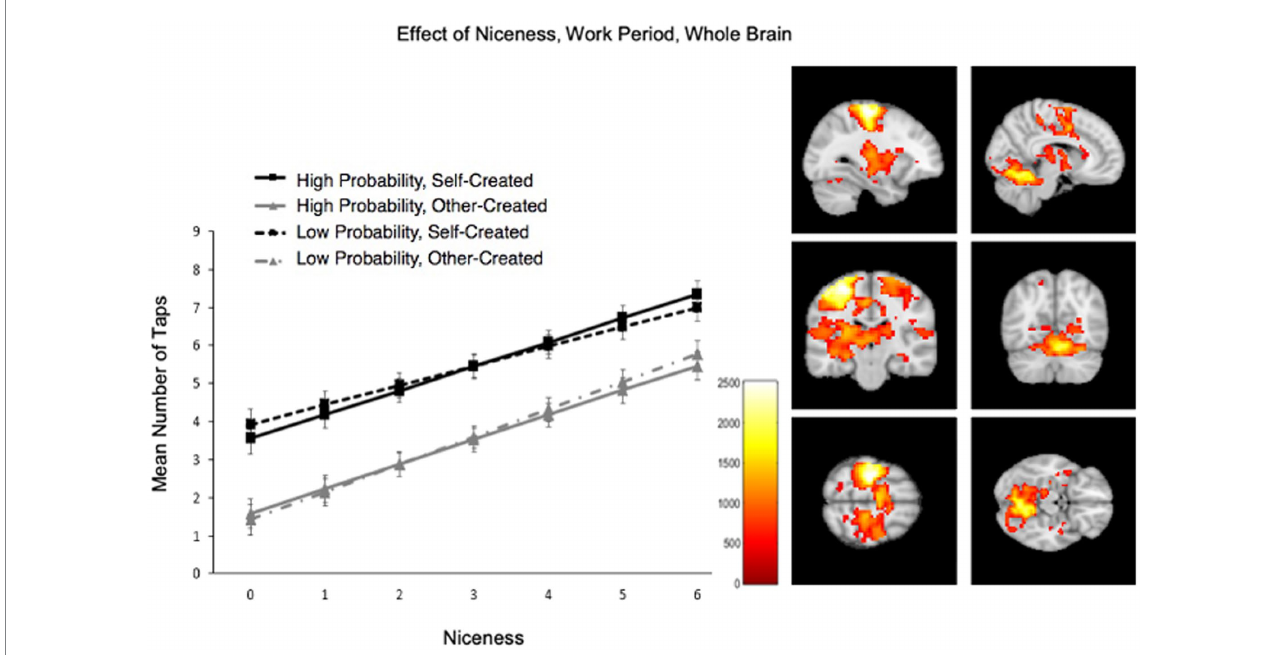
FIGURE 4 Increased effort for Self > Other and item niceness. Participants worked harder for their own over other’s items and for ones rated as nicer. Self items in black; Other in gray; dashed lines represent low loss probability; solid represent high loss probability. Brain activation from whole brain (WB) analysis during the Work period when tapping more for nicer pretzels.